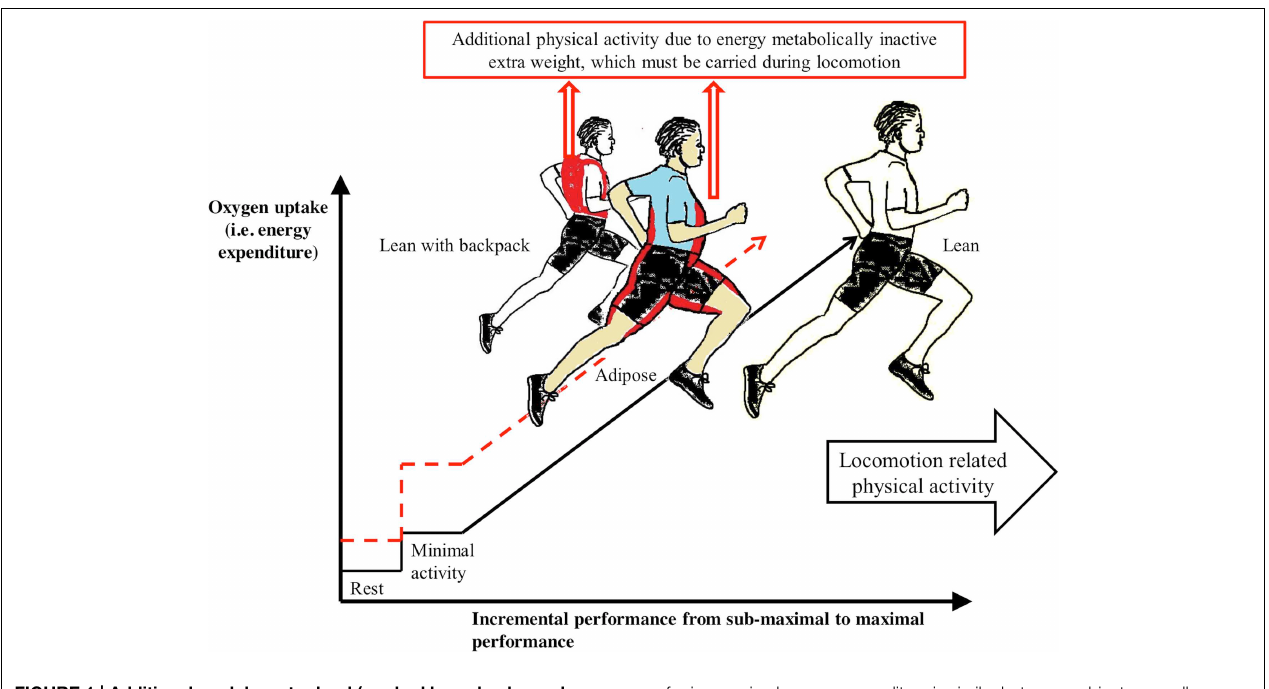
referring maximal energy expenditure is similar between subjects as well as lean mass. Increase of oxygen uptake by exercise does not differ between lean (solid line), adipose and lean with backpack subjects (Wasserman et al., 2005). Dimensions of the curves are normative and directional.